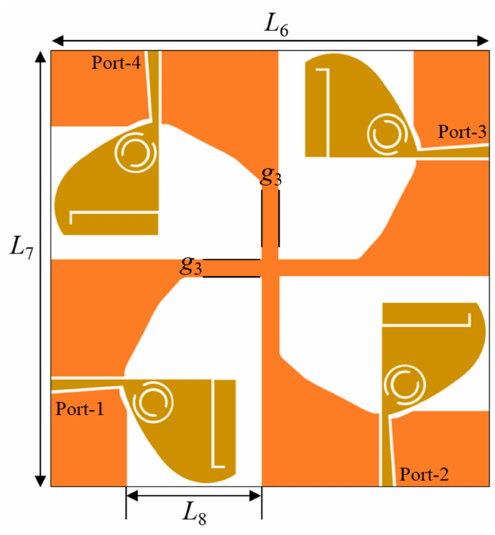
Figure 6. Geometric layout of the proposed TSESC multiple-input–multiple-output (MIMO)